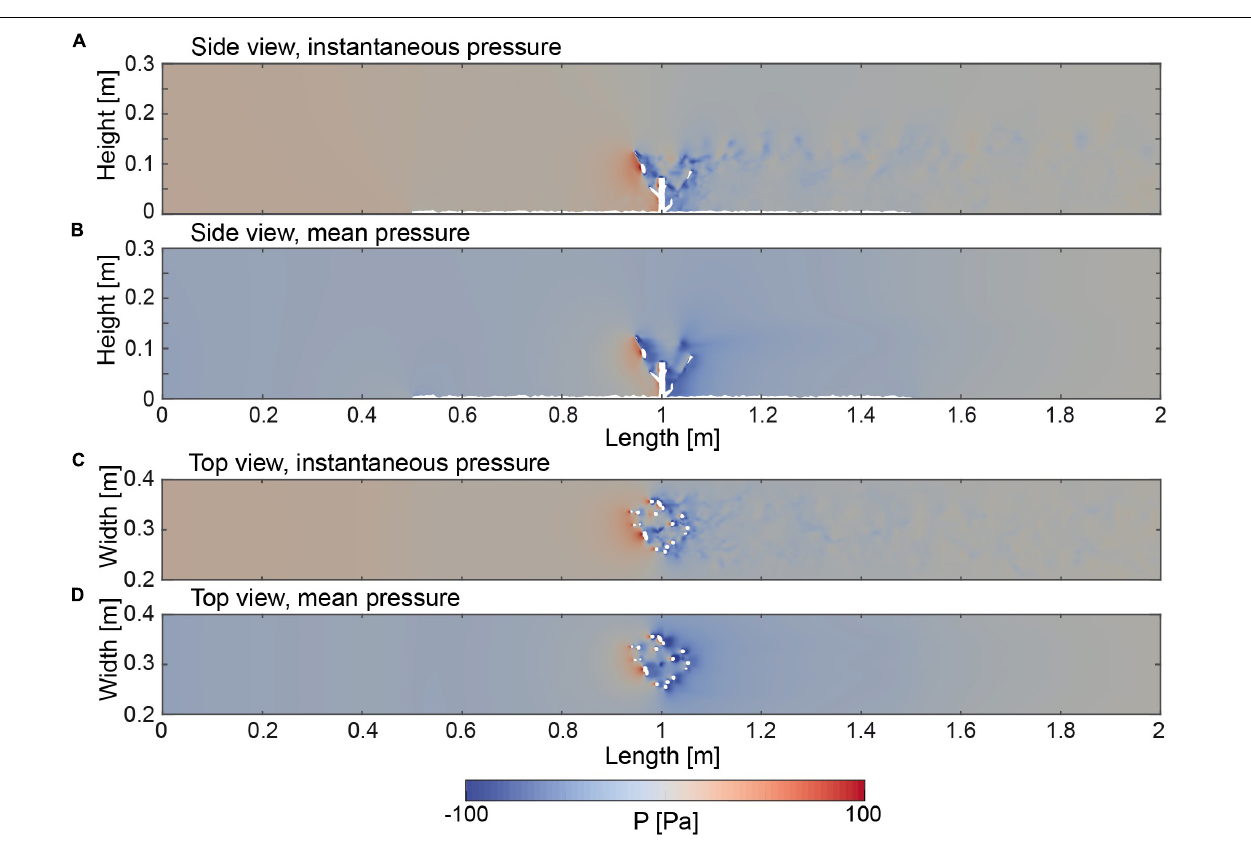
velocity zone that ranges from the rear toward the end of the domain. Moreover, the isosurface indicates that this hull was lower in height in the upstream direction and appeared lower